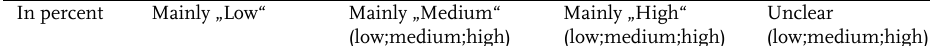
Table A.7 : Average belonging to sending and receiving contexts based on cases for female immigrants In